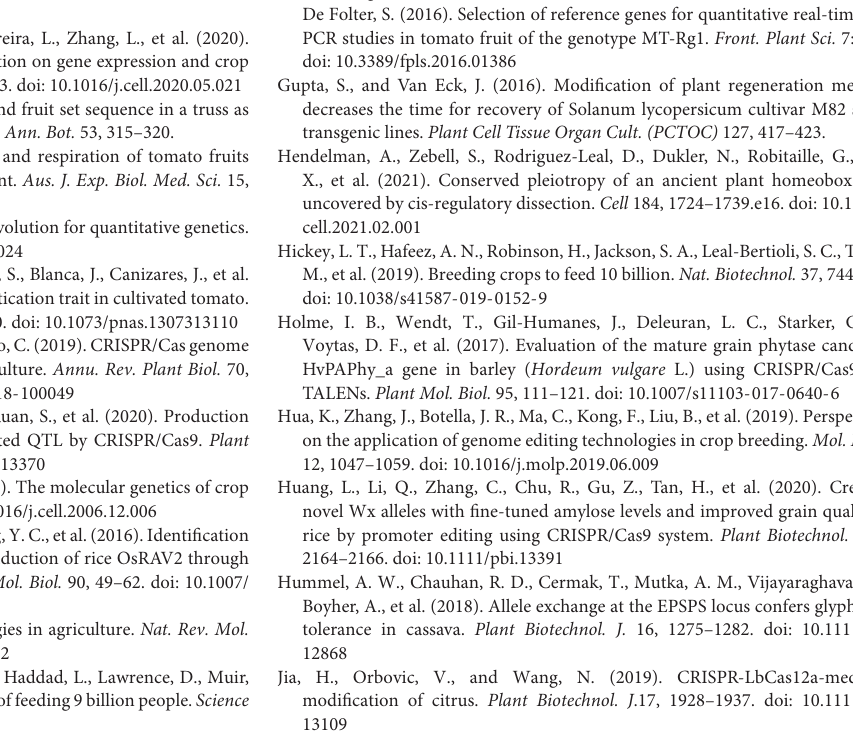
Red letters indicate mismatches. Y with green highlight indicates the M9 SNP (C-Wild type; T-Cultivated). Supplementary Figure 2 | PCR genotyping of T 0 transgenic lines. Blue arrowhead indicated heteroduplex. Supplementary Figure 3 | Detection novel mutant alleles in the target site. Left panel, Sequences of the six mutant alleles with small indels (less than 5 bp) and recognition sequences of the three restriction enzymes (REs). Inserted and deleted nucleotide(s) were shown in red and gray, respectively. The yellow highlighted nucleotides indicate the mismatches to the wild-type ( wt ) allele. Right panel, Schematic of the PCR and RE assay. The short lines with different colors and dash types indicate the alleles that were shown in the left panel. Supplementary Figure 4 | PCR/RE analysis-based genotyping of F 1 plants. The small indels that cannot be easily observed by gel electrophoresis mobility shift using PCR assays will be genotyped by dCAPS- Bsr BI, dCAPS- Hae III, and dCAPS- Aci I. The primers of PCR/RE assays were listed in Supplementary Table 4 . The corresponding plant numbers of the alleles were shown in Supplementary Table 2 . Supplementary Figure 5 | Fruit weight distribution analysis of mutants in LA1589 background in December 2018 (A) , May 2019 (B) , and September 2019 (C) . Data are presented as the percentage of fruits per fruit weight category. Asterisks denote significant difference ( ∗ P < 0.05; ∗∗ P < 0.01; ∗∗∗ P < 0.001) of the proportion of small fruit (gray bar) between mutants and LA1589 as determined by chi-squared test. Supplementary Figure 6 | Fruit weight analysis based on fruit position on inflorescence in LA1589. (A) Fruit weight decreases from proximal to the distal end. Fruit position 1–8 indicates the 1st (proximal) to 8th (distal) fruit on inflorescence as shown in panel (B) . Supplementary Figure 7 | Young flower buds at 9–13 days post initiation (dpi) indicated by red arrows are used for SlKLUH expression